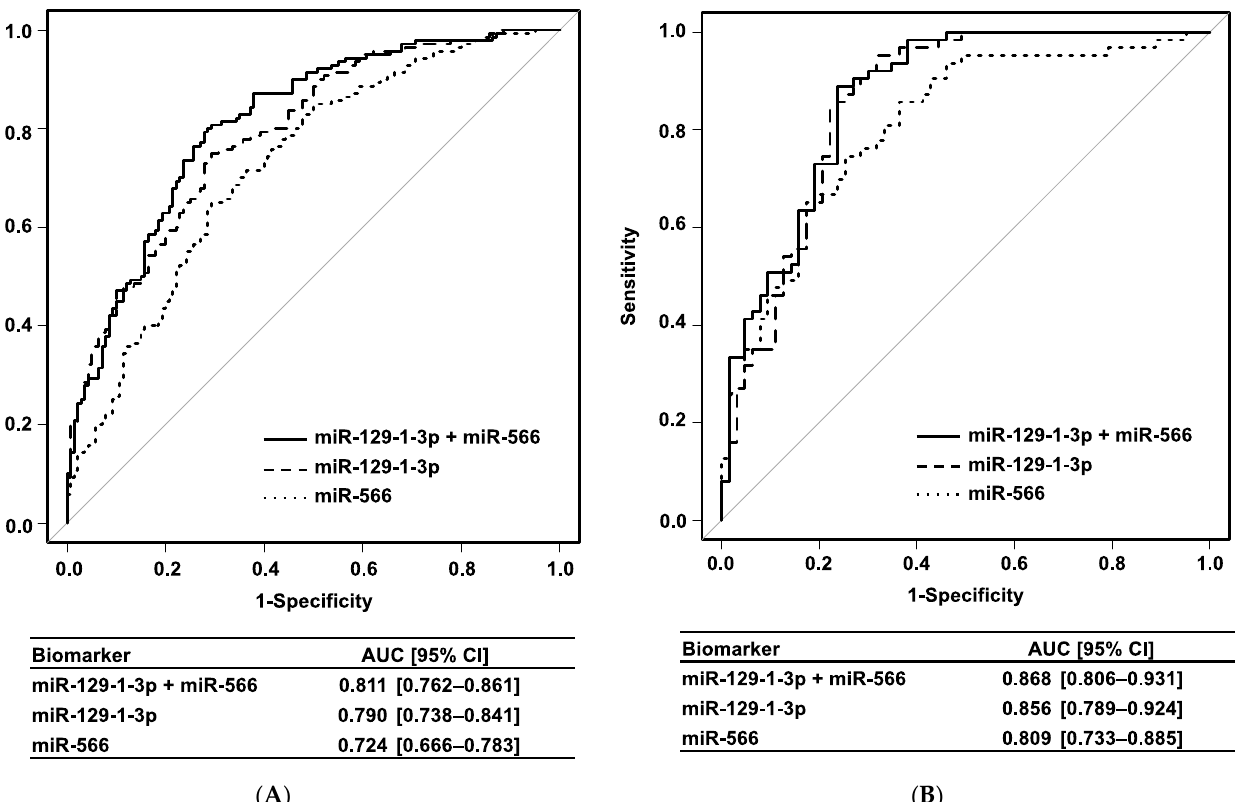
Figure 2. Receiver operating characteristics curves. ( A ) Training cohort. ( B ) Validation cohort. AUC, area under the curve; 95% CI, 95% confidence interval.